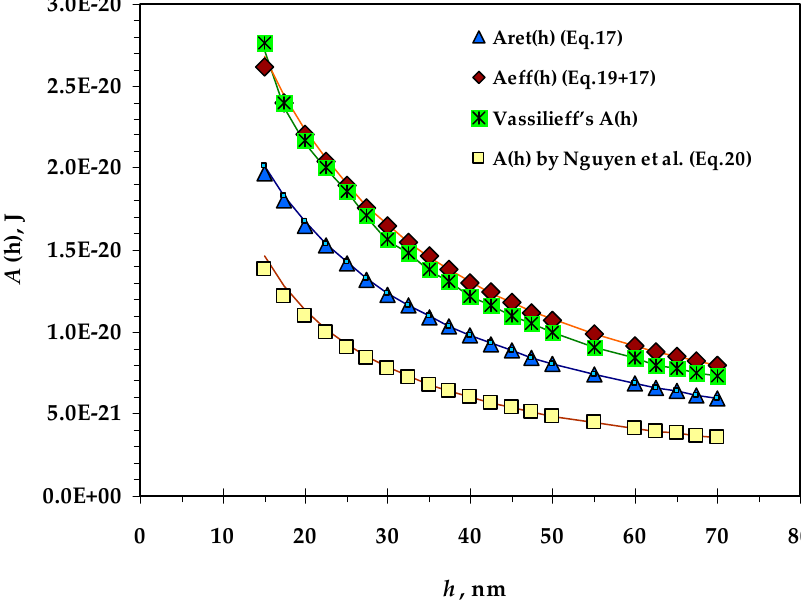
Figure 1. Comparison of the calculated data of Hamaker function by different equations at two ionic strengths 0.1 М (markers) and 0.001 M (lines) for monovalent electrolytes. 3.2. Comparison between Measured and Calculated Critical Thickness Values for Foam Films Stabilized by Nonionic n-Dodecyl- β -D-maltoside (C 12 G 2 ) and by Cationic Surfactant n-Dodecyl Trimethyl Ammonium